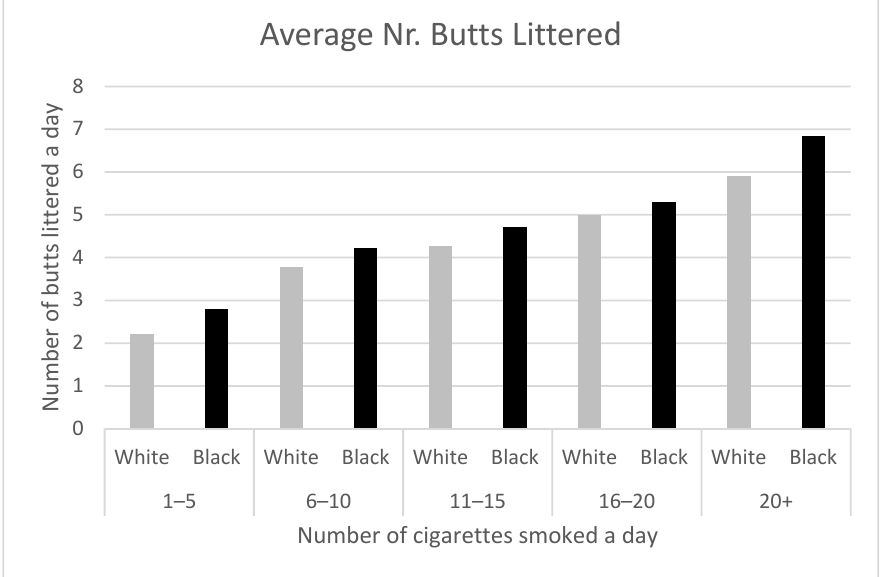
Figure 6. Average per person number of cigarette butts improperly disposed of by race according to number of cigarettes smoked each day ( n = 6461).